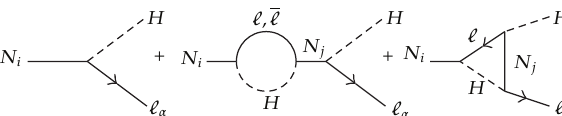
Figure 1: The CP asymmetry in type-I seesaw leptogenesis results from the interference between tree and 1-loop wave and vertex diagrams. For the 1-loop wave diagram, there is an additional contribution from L -conserving diagram to the CP asymmetry which vanishes when summing over lepton flavours.